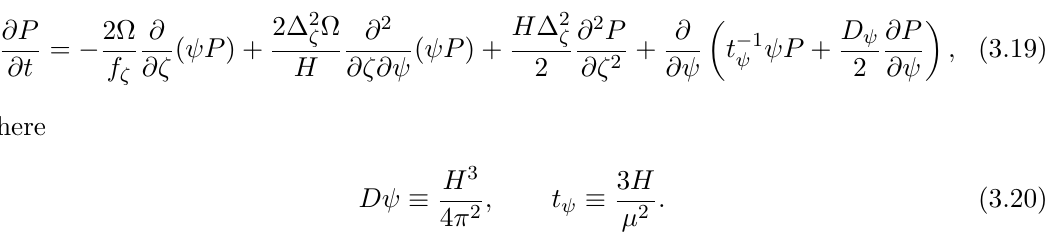
Figure 1 . We plot the scale invariant power spectra (3.16) amd (3.17). We set ∆ 0 The parameters for the black line are µ = 0 . 2 H , Ω = . 05 , the orange line µ = 0 . 2 H , Ω = . 2 H and for the gray line µ = . 05 H , Ω = . 2